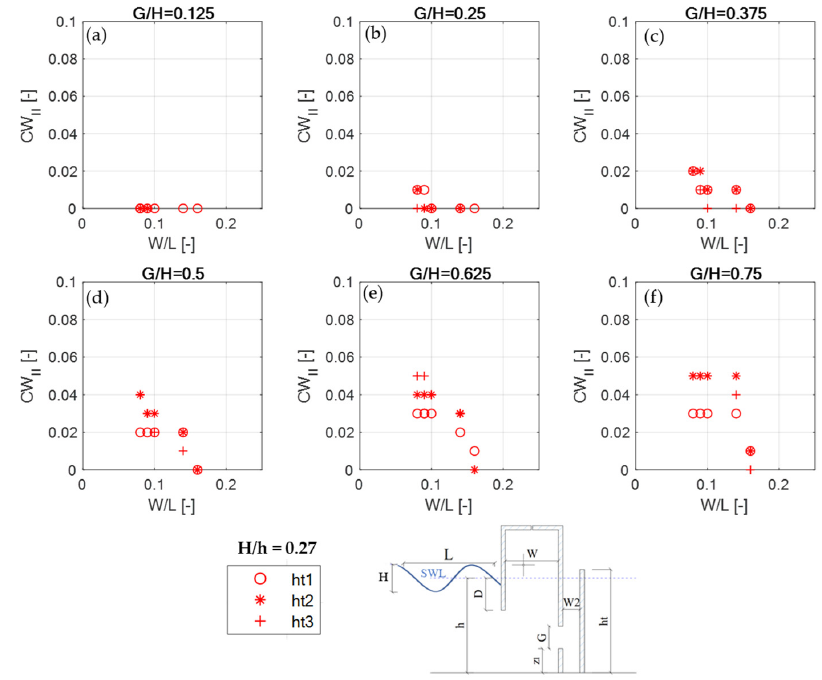
Figure A1. Capture width of the overtopping-based component of the device, CW II , as a function of the width of the OWC chamber, W / L , for different sizes of the aperture in the back wall relative to the incident wave height G / H = 0.125 ( a ), 0.25 ( b ), 0.375 ( c ), 0.5 ( d ), 0.625 ( e ), 0.75 ( f ). Results obtained with the wave height H / h = 0.20.